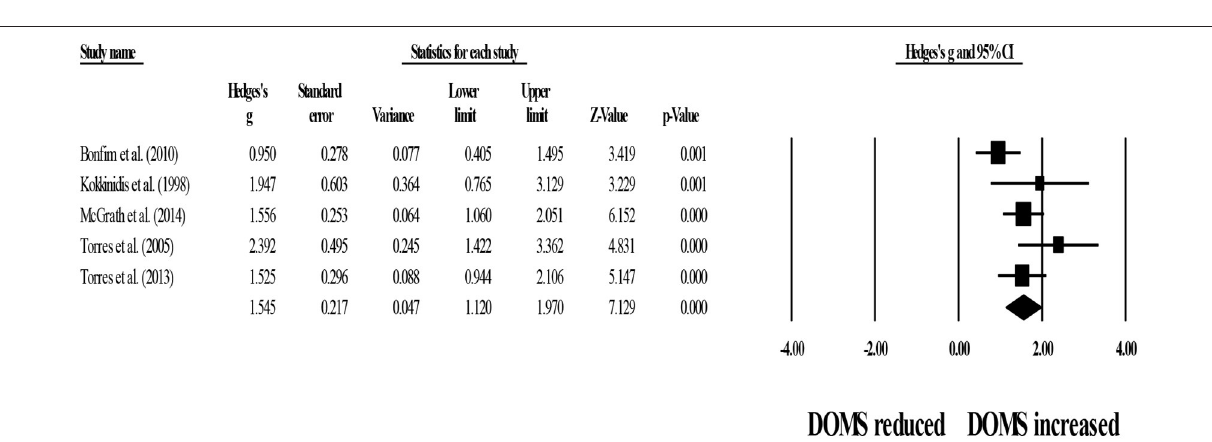
FIGURE 6 | Forest plot denoting 24-h post-exercise delayed onset of muscle soreness (DOMS) in participants that completed post-exercise stretching protocols. Values shown are effect sizes (Hedges’s g) with 95% confidence intervals (CI). The size of the plotted squares reflects the statistical weight of each study. The black diamond reflects the overall result. Note: positive values denote that post-exercise stretching protocols did not allow participants to recover their basal DOMS level (i.e., 0.00 in the